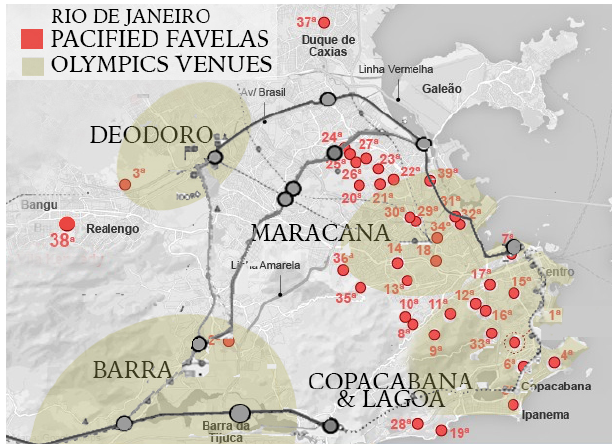
Figure 1. Map of Rio de Janeiro showing pacified fave- las in relation to Olympic venues, tourist sites, and major transportation